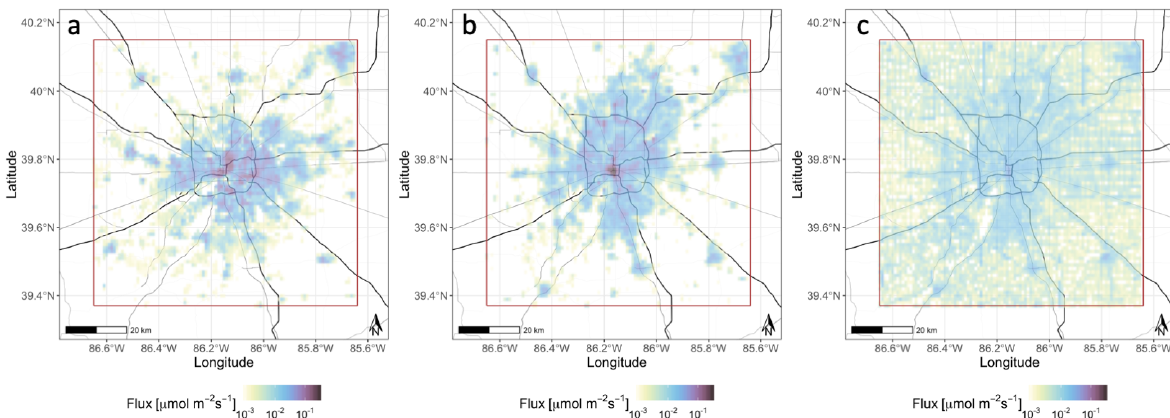
Figure 9. Diffuse emission spatial distributions based on (a) HESTIA, (b) population, and (c) road density. Map tiles by Stamen Design under CC BY 3.0. Data by OpenStreetMap; © OpenStreetMap contributors 2020. Distributed under the Open Data Commons Open Database License (ODbL) v1.0.